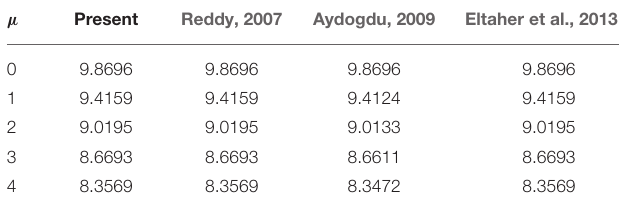
TABLE 1 | Comparisons of first fundamental frequency parameter ( λ ) for SS Nano beam.